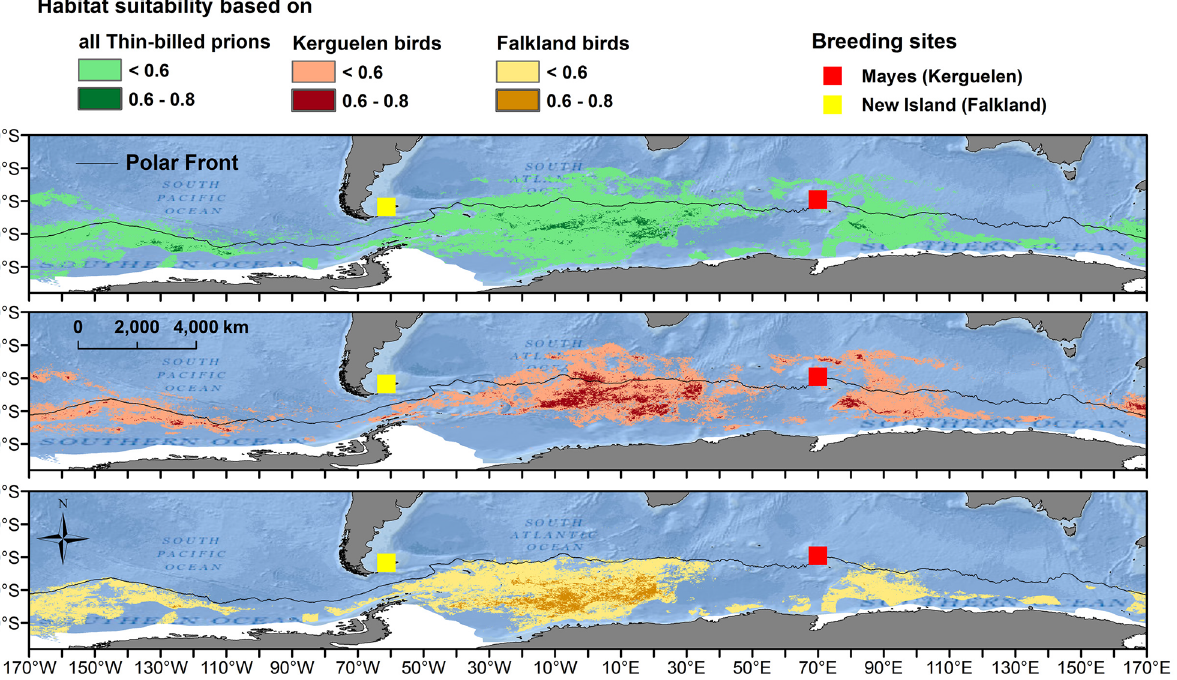
Fig 3. Habitat suitability models of thin-billed prions from the Falkland and Kerguelen Islands. Habitat values from M AX E NT models of the nonbreeding distribution of thin-billed prions from the Falkland and Kerguelen Islands. Values below the 10th percentile training presence logistic threshold (see Table 1) were